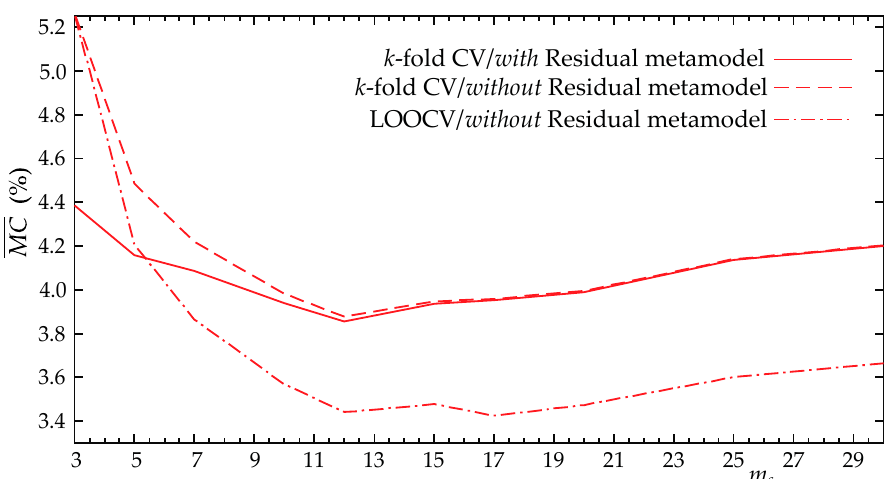
S surrogate model for different number of Figure 9. Averaged misclassification MC for the Figure 9. Averaged misclassification MC for the S c surrogate model for different number of com- c m without considering the node grid connectivity. Different metamodel variants components ( ) ponents ( m c ) without considering the node grid connectivity. Different metamodel variants (use of c (use of additional metamodel on the residuals) and different validation approaches are shown. additional metamodel on the residuals) and different validation approaches are